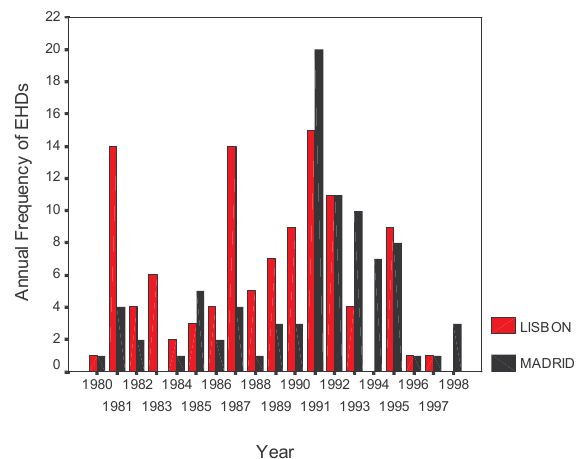
Fig. 4. Annual frequencies of EHDs for Lisbon (light columns) and Madrid (dark columns) for the longer periods of